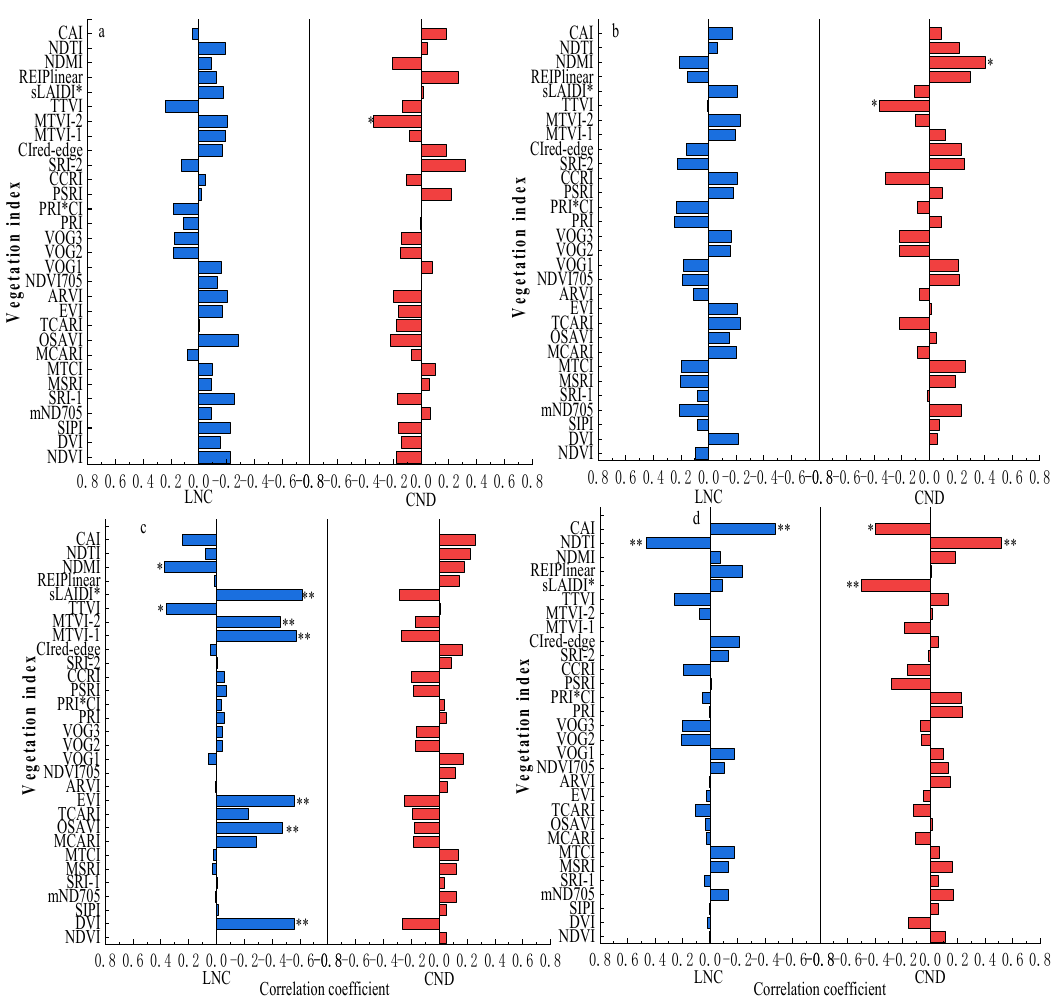
Figure 5. Correlations between LNC, CND, and vegetation index in 2019 (Xinluzao 45, ( a ): bud stage; ( b ): initial flowering stage; ( c ): flowering and boll stage; ( d ): full-boll period. * Indicates that significant difference is achieved under p < 0.05; ** indicates that significant difference is achieved under p <